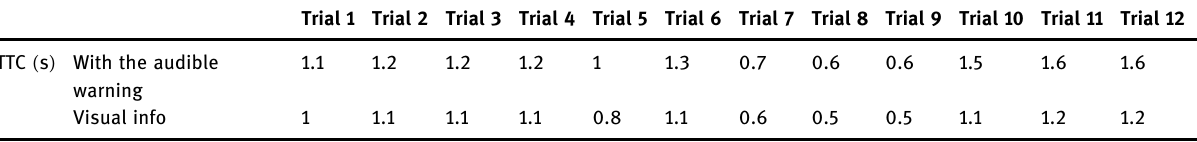
Table 6: Time to a collision when a warning sounded in the individual trials for scenario 2